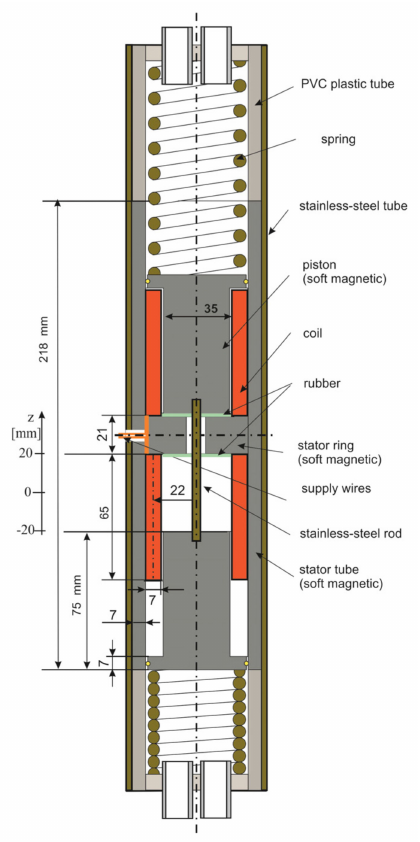
Figure 2. Scheme of the switched reluctance linear tubular motor, with its main dimensions.